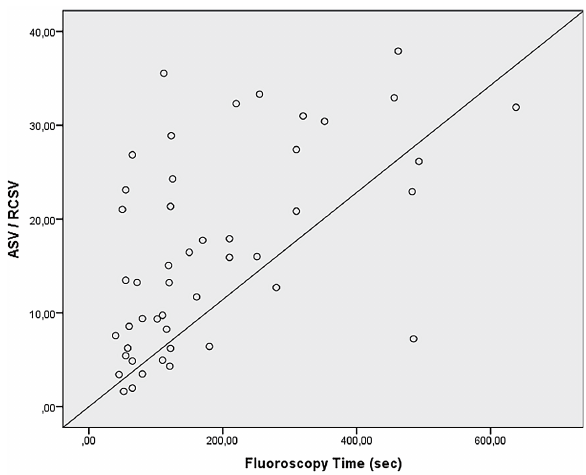
Figure 2 - Correlation between ASV-to-RCSV ratio and Fluoroscopy